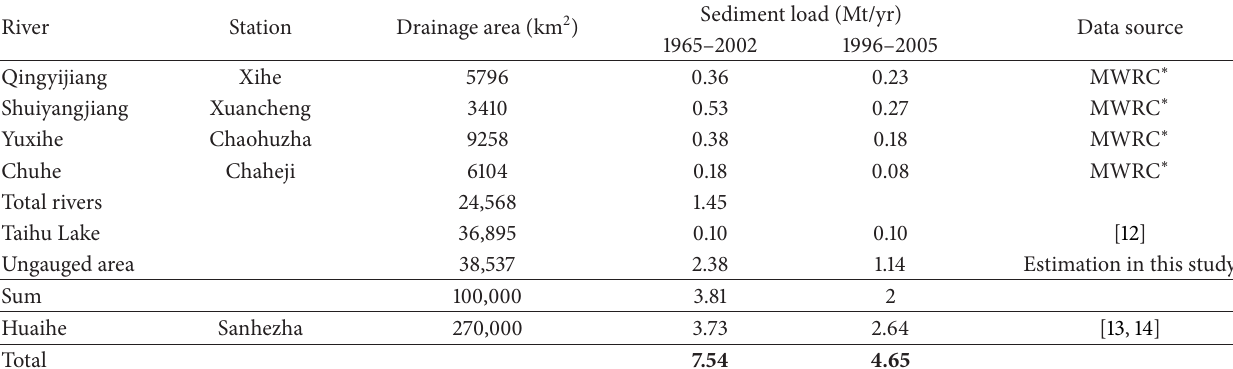
Table 1: Sediment load of the tributaries of the river mouth reach of the Yangtze River.